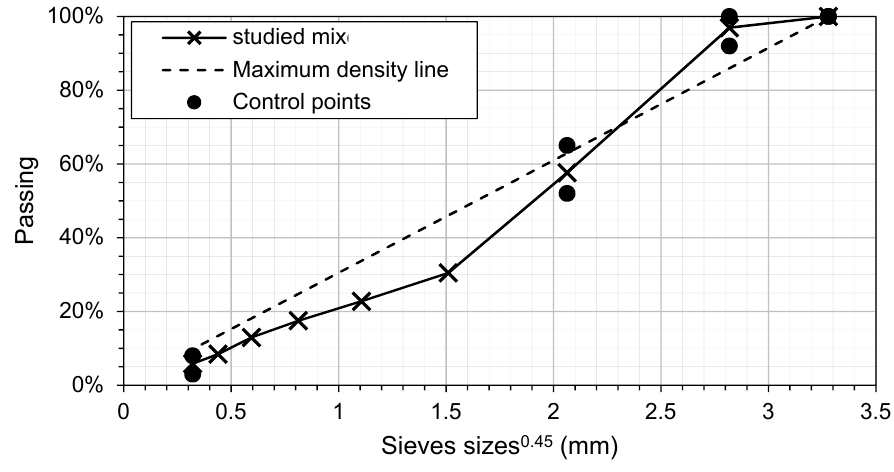
Figure 2. Particle size distribution of studied mix.